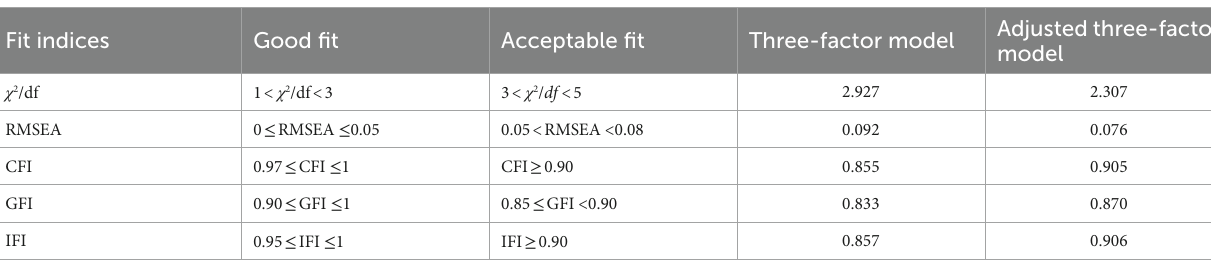
TABLE 3 Fit indices of the models ( N =